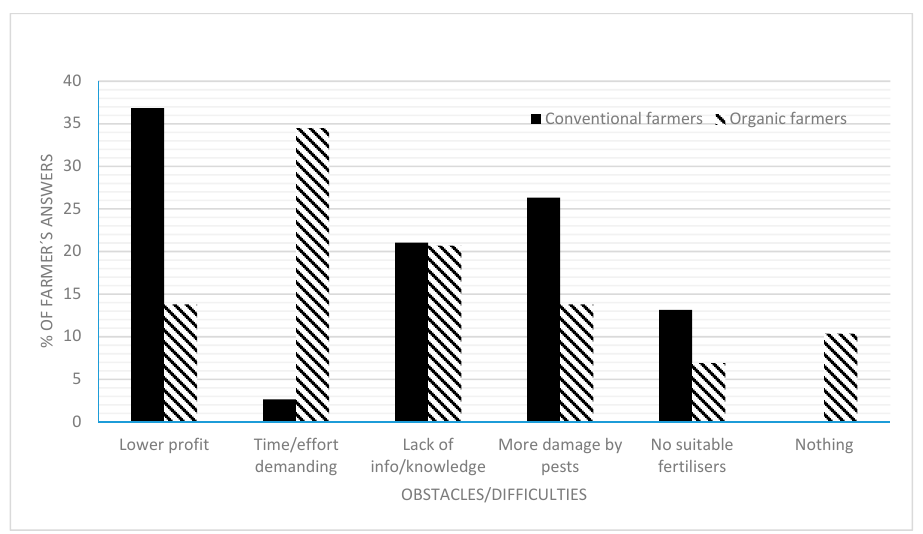
Figure 3. Difficulties with organic farming as perceived (open-ended question) by organic ( n = 16) and conventional ( n = 23) olive farmers in in Messenia, Greece.